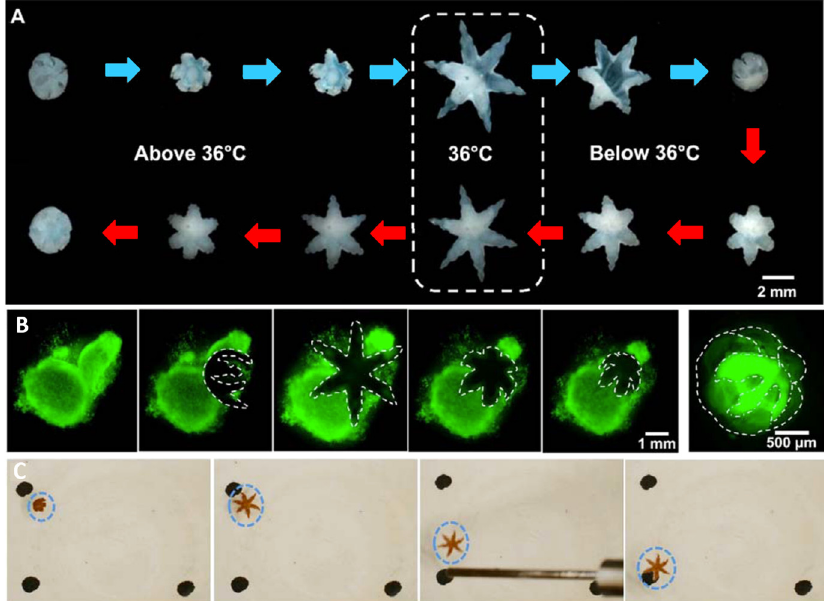
Figure 10. In vitro verification of thermomagnetic-responsive microgrippers. ( A ) PPF and pNIPAM- AAc microgrippers demonstrated the ability to self-fold and unfold with temperature changes for over 50 cycles. ( B ) Microgrippers demonstrated the ability to excise and capture fibroblast cells from a cell clump. Dashed lines indicate the boundary of the clear microgripper. ( C ) Polymeric microgrippers doped with iron oxide were able to be guided from one marker to another with a magnetic probe. Adapted with permission from Ref. [9]. Copyright 2015.